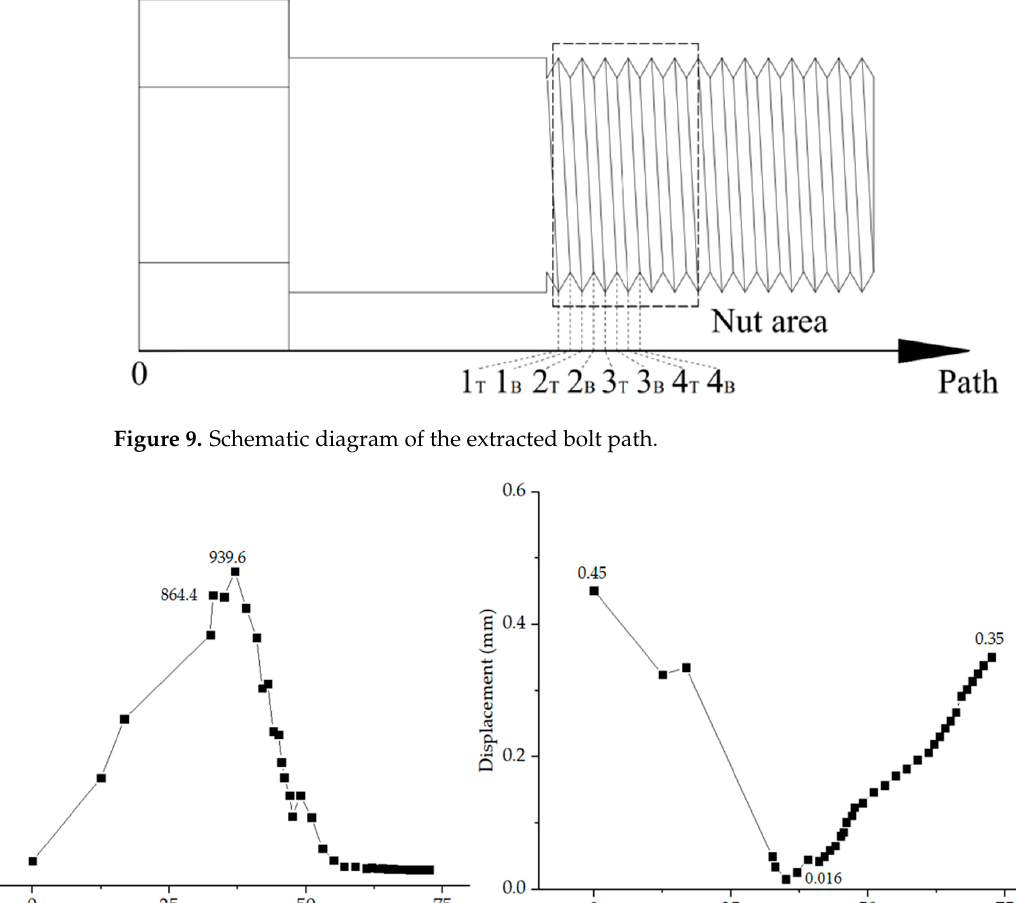
Figure 8. Bolt Stress Results: ( a ) Model stress nephogram under linear load; ( b ) Model displacement nephogram under seismic load; ( c ) Stress simulation diagram of UDHSB under linear load; ( d ) Stress simulation diagram of UDHSB under seismic load.